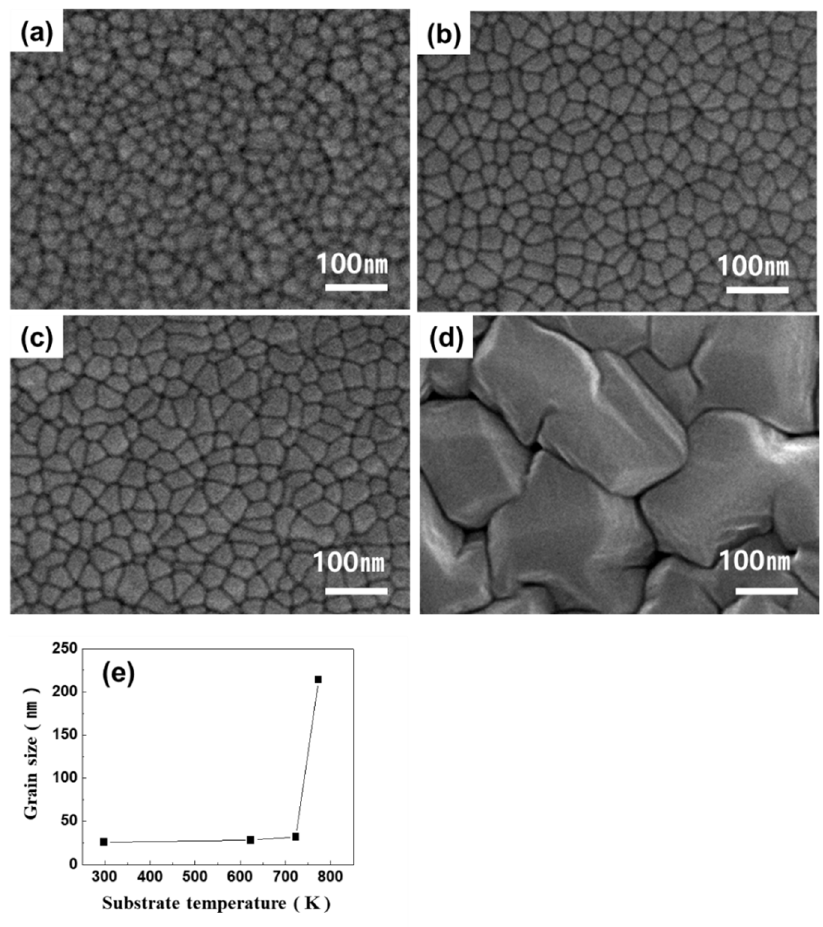
Figure 4. FE-SEM images of Ti-50.0 ± 0.3Ni (at %) thin film with substrate temperatures of ( a ) 293 K, ( b ) 623 K, ( c ) 723 K, and ( d ) 773 K; and ( e ) relationship between grain size and substrate temperatures. (Deposition condition: growth rate (6.29 nm/min), thickness (1.7 μm)).